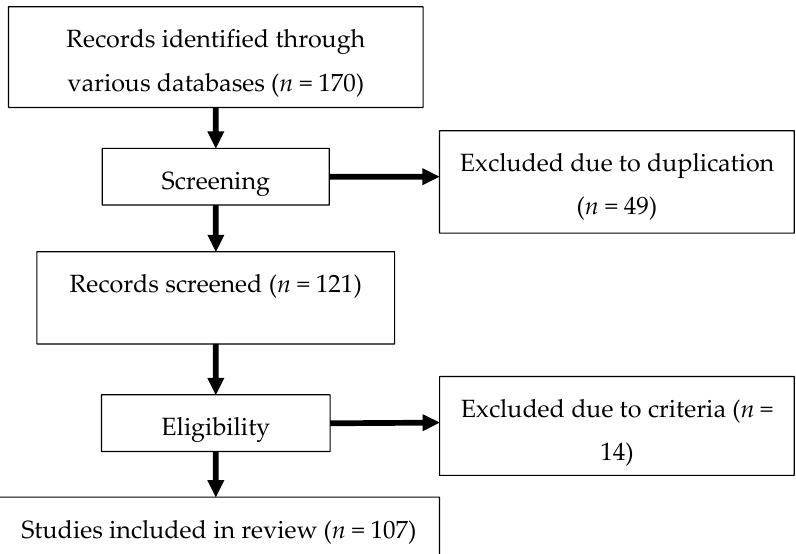
Figure 1. Flow chart of review process in article selection.